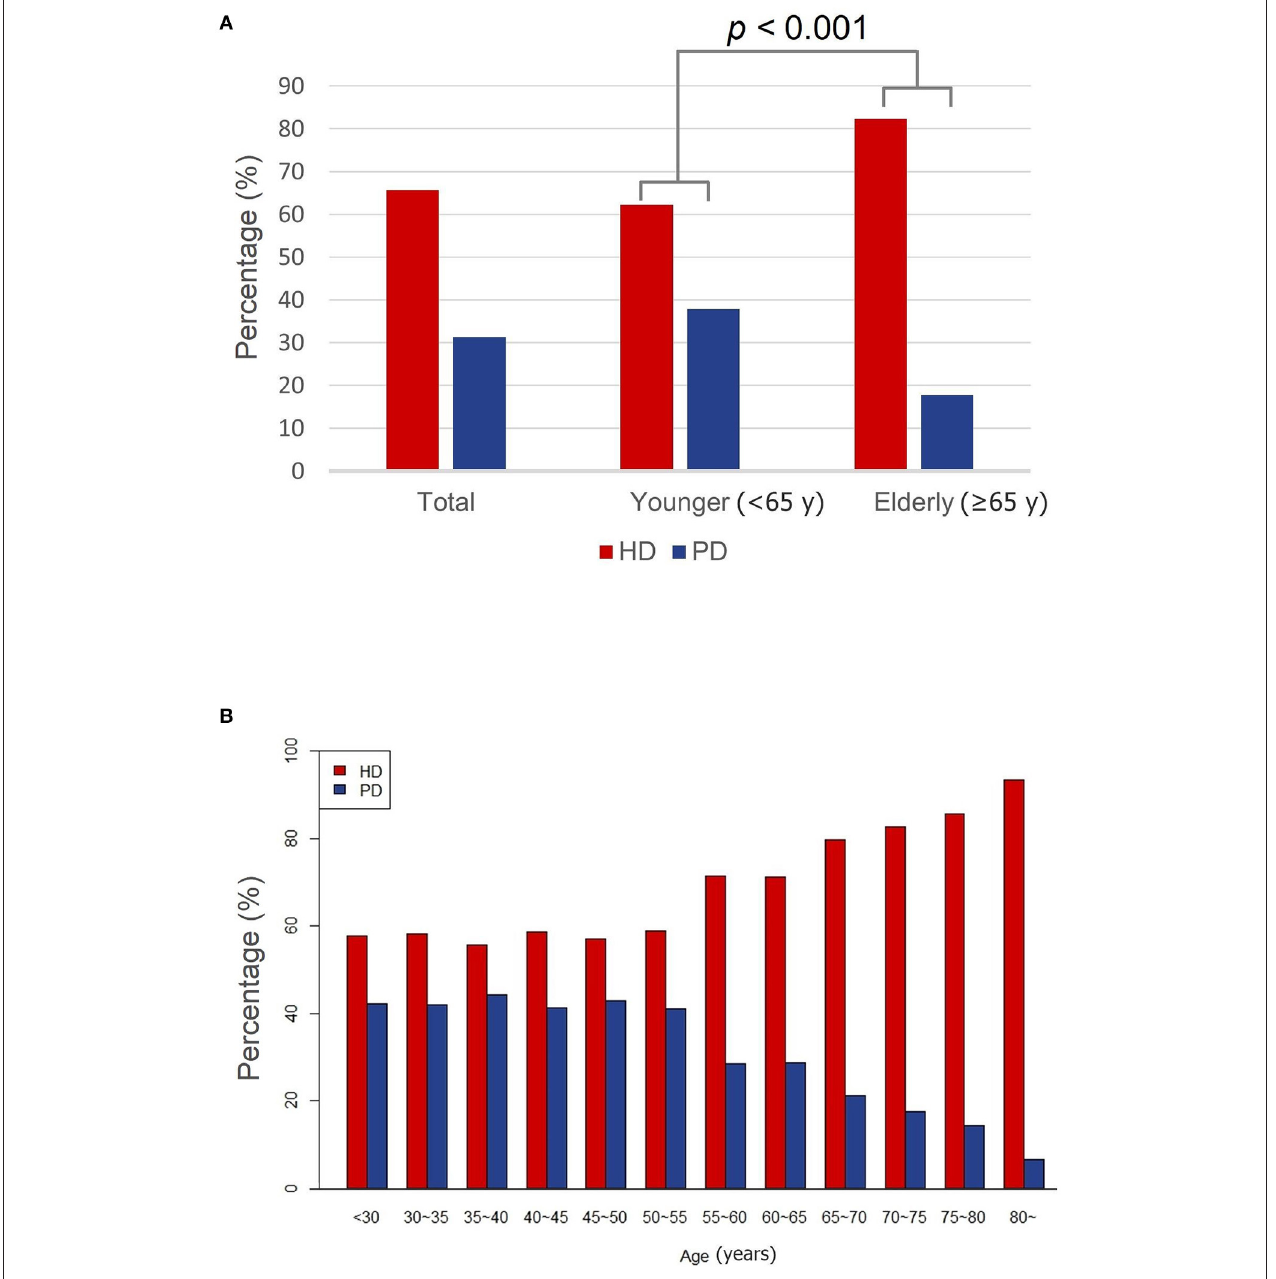
FIGURE 1 | The proportion of dialysis modalities. (A) The proportion of dialysis modalities of younger and elderly groups. (B) The proportion of dialysis modalities by age group. HD, hemodialysis; PD, peritoneal dialysis; y,